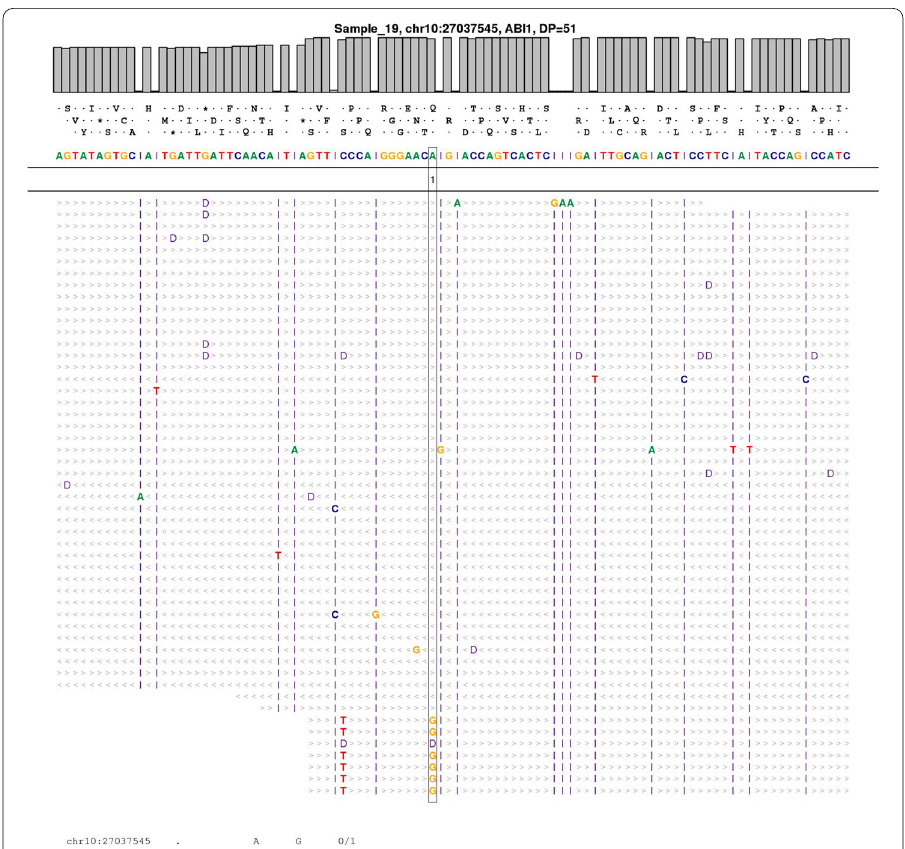
Fig. 3 An example snapshot of probable sequencing artifact at